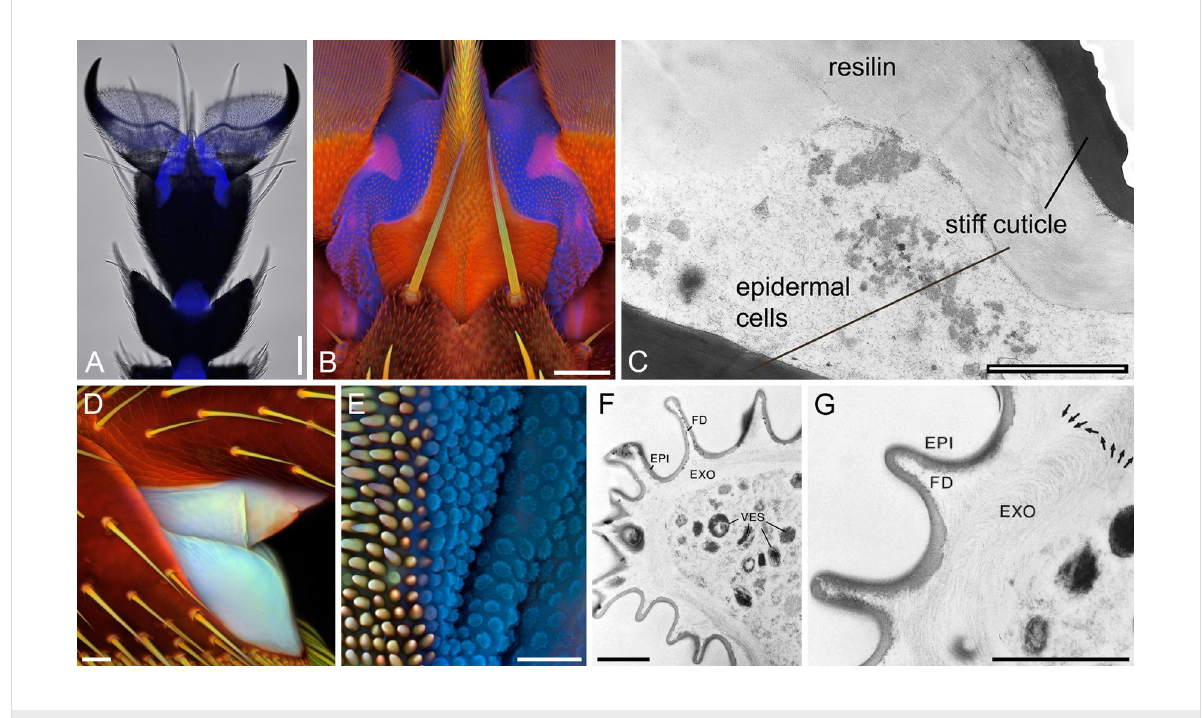
Figure 3: Resilin in arthrodial membranes of insects. (A, B) Pretarsus of the drone fly ( Eristalis tenax ), ventral view. (A) Overlay of a bright-field micro- graph and a wide-field fluorescence micrograph showing the presence and distribution of resilin autofluorescence (blue). (B) Confocal laser scanning micrograph (maximum intensity projection) revealing large proportions of resilin (shown in blue) in the membranous structures between rigid sclerites of the pretarsus. (C) Pretarsus of the urban bluebottle blowfly ( Calliphora vicina ). Transmission electron micrograph showing an ultra-thin section through structures comparable to those shown in blue in B. (D) Lateral view of the joint between the tarsomeres 1 and 2 in the third leg of the seven- spot ladybird ( Coccinella septempunctata ). (E) Border between the neck membrane (right side) and a postcervical sclerite (left side) of the broad- bodied chaser ( Libellula depressa ). (F, G) Membranous cuticle in the neck area of the blue-tailed damselfly ( Ischnura elegans ). Transmission elec- tron micrographs showing ultra-thin sections. EPI, epicuticle; EXO, exocuticle; FD, folds; VES, vesicles. Arrows: preferential orientation of chitin fibres. Scale bars = 100 µm (A), 50 µm (B), 2 µm (C), 20 µm (D, E), 1 µm (F, G). (A, B, D, E) Adapted with permission from [10], copyright 2011 John Wiley and Sons. (F, G) Adapted with permission from [69], copyright 2000 The Zoological Society of